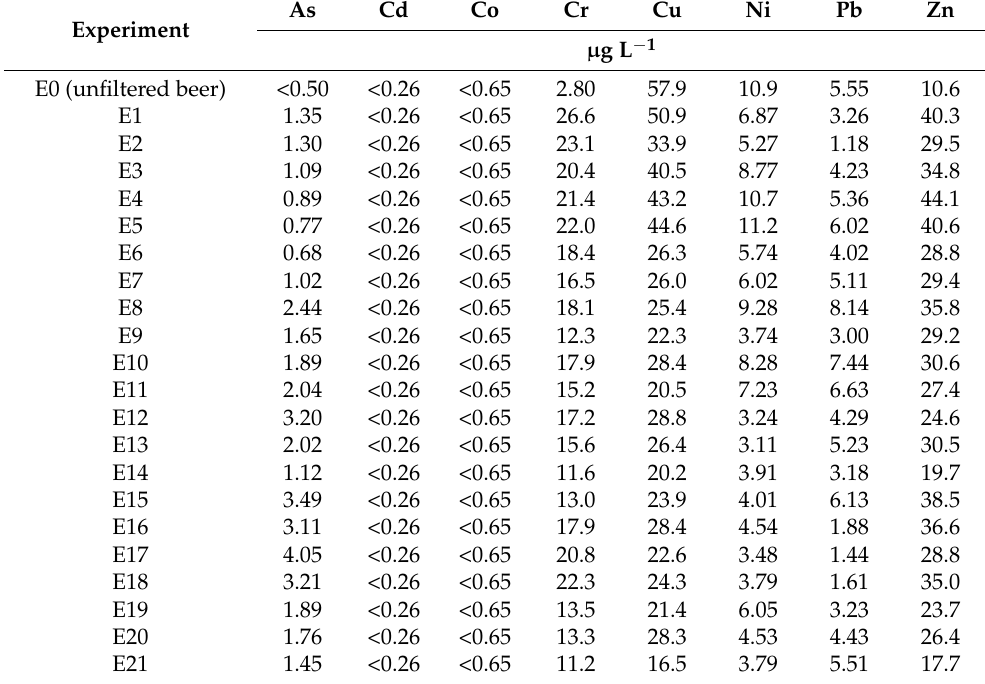
Table 6. Contents of trace elements (As, Cd, Co, Cr, Cu, Ni, Pb, and Zn) in unfiltered and filtered beer samples measured by